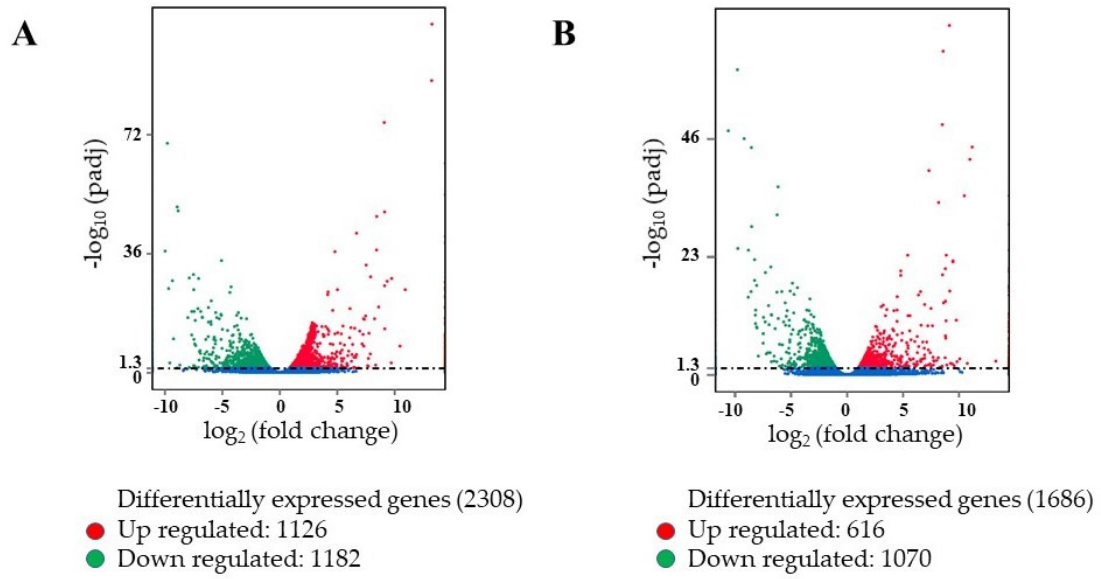
Figure 1. The volcano maps showing the number of differentially expressed genes in PI 175311 vs. Bloomsdale leaf ( A ) and root ( B ) tissues. Red dots represent upregulated genes, and green dots represent downregu-lated genes ( p < 0.05). The x -axis shows the fold change of genes between different samples (padj < 0.05), and the y -axis coordinate indicates the statistically significant degree of changes in gene expression levels at − log10(padj p -value).